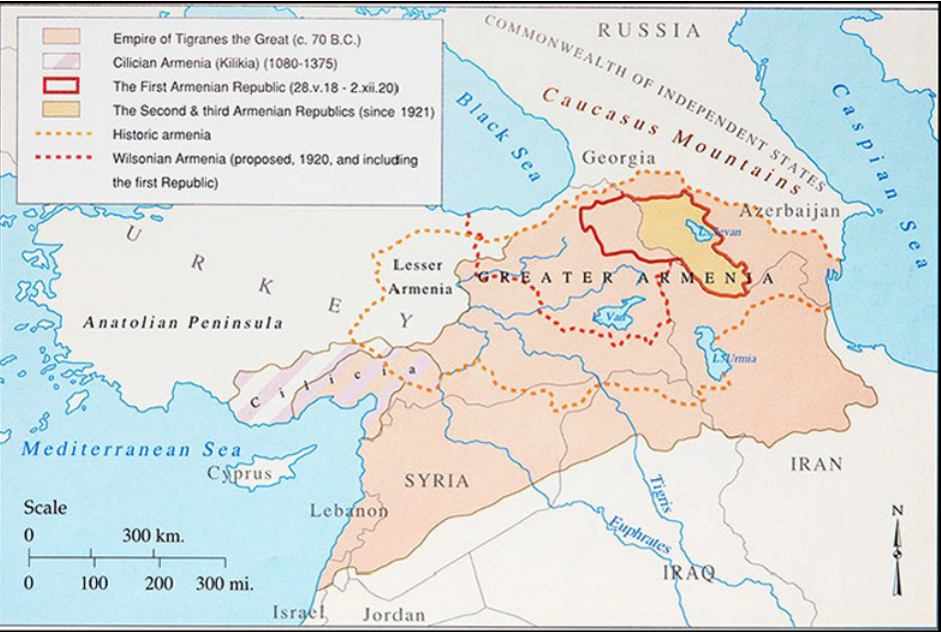
The territory from which the ancestors of Western Armenian-speakers originated—labelled ‘Wilsonian Armenia’ and Historic Armenia/Cilician Armenia (Hewsen